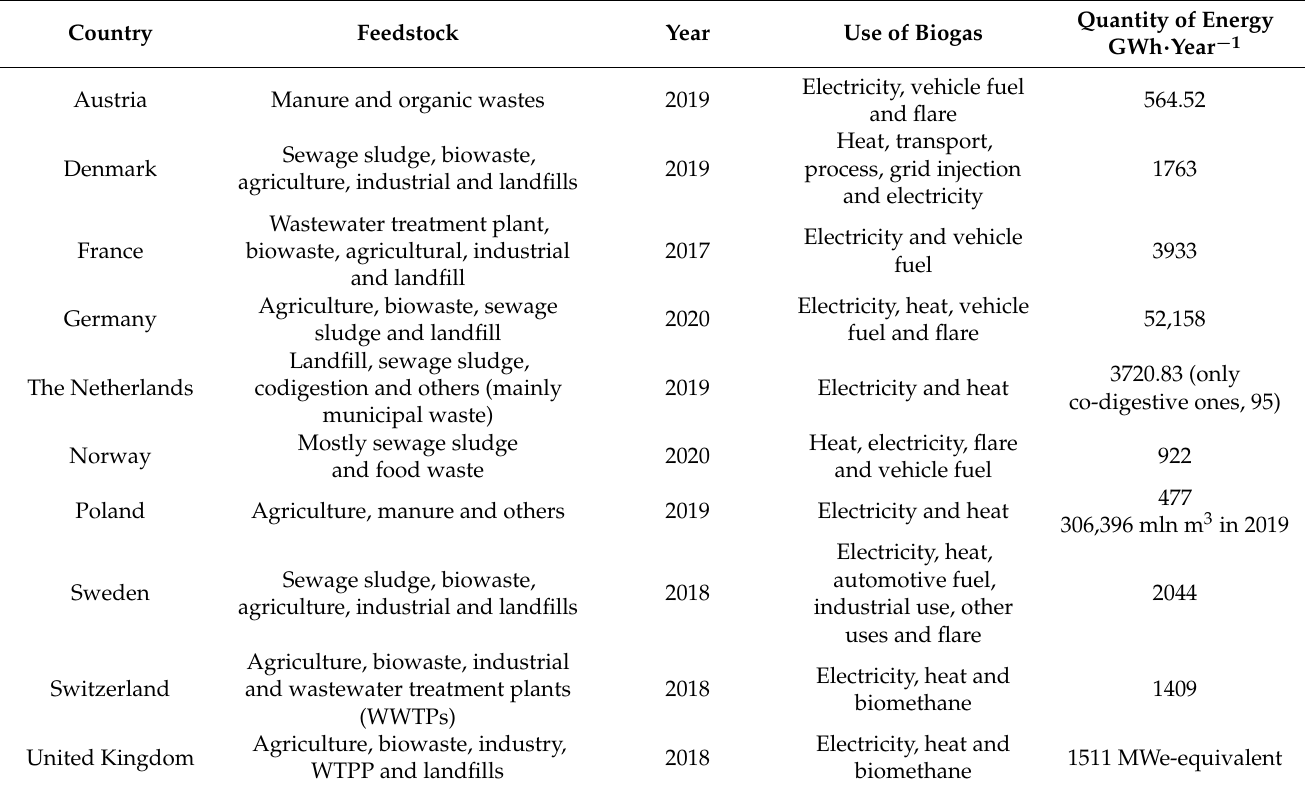
Table 1. Biogas plant status in Europe—selected examples. Own elaboration according to data: